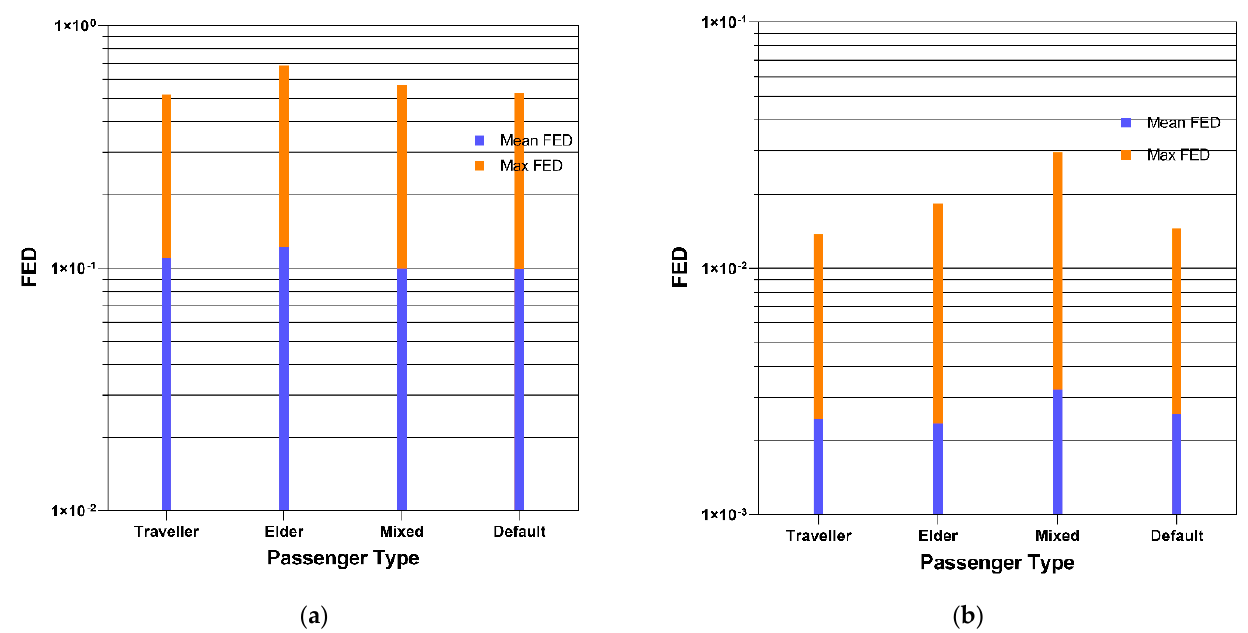
Figure 6. Mean and max FED index values for each passenger type for the ( a ) ventilated and ( b ) non-ventilated scenarios. The values never exceed the critical value of 1 but in the ventilated scenario the FED values are an order of magnitude higher than the non-ventilated one.